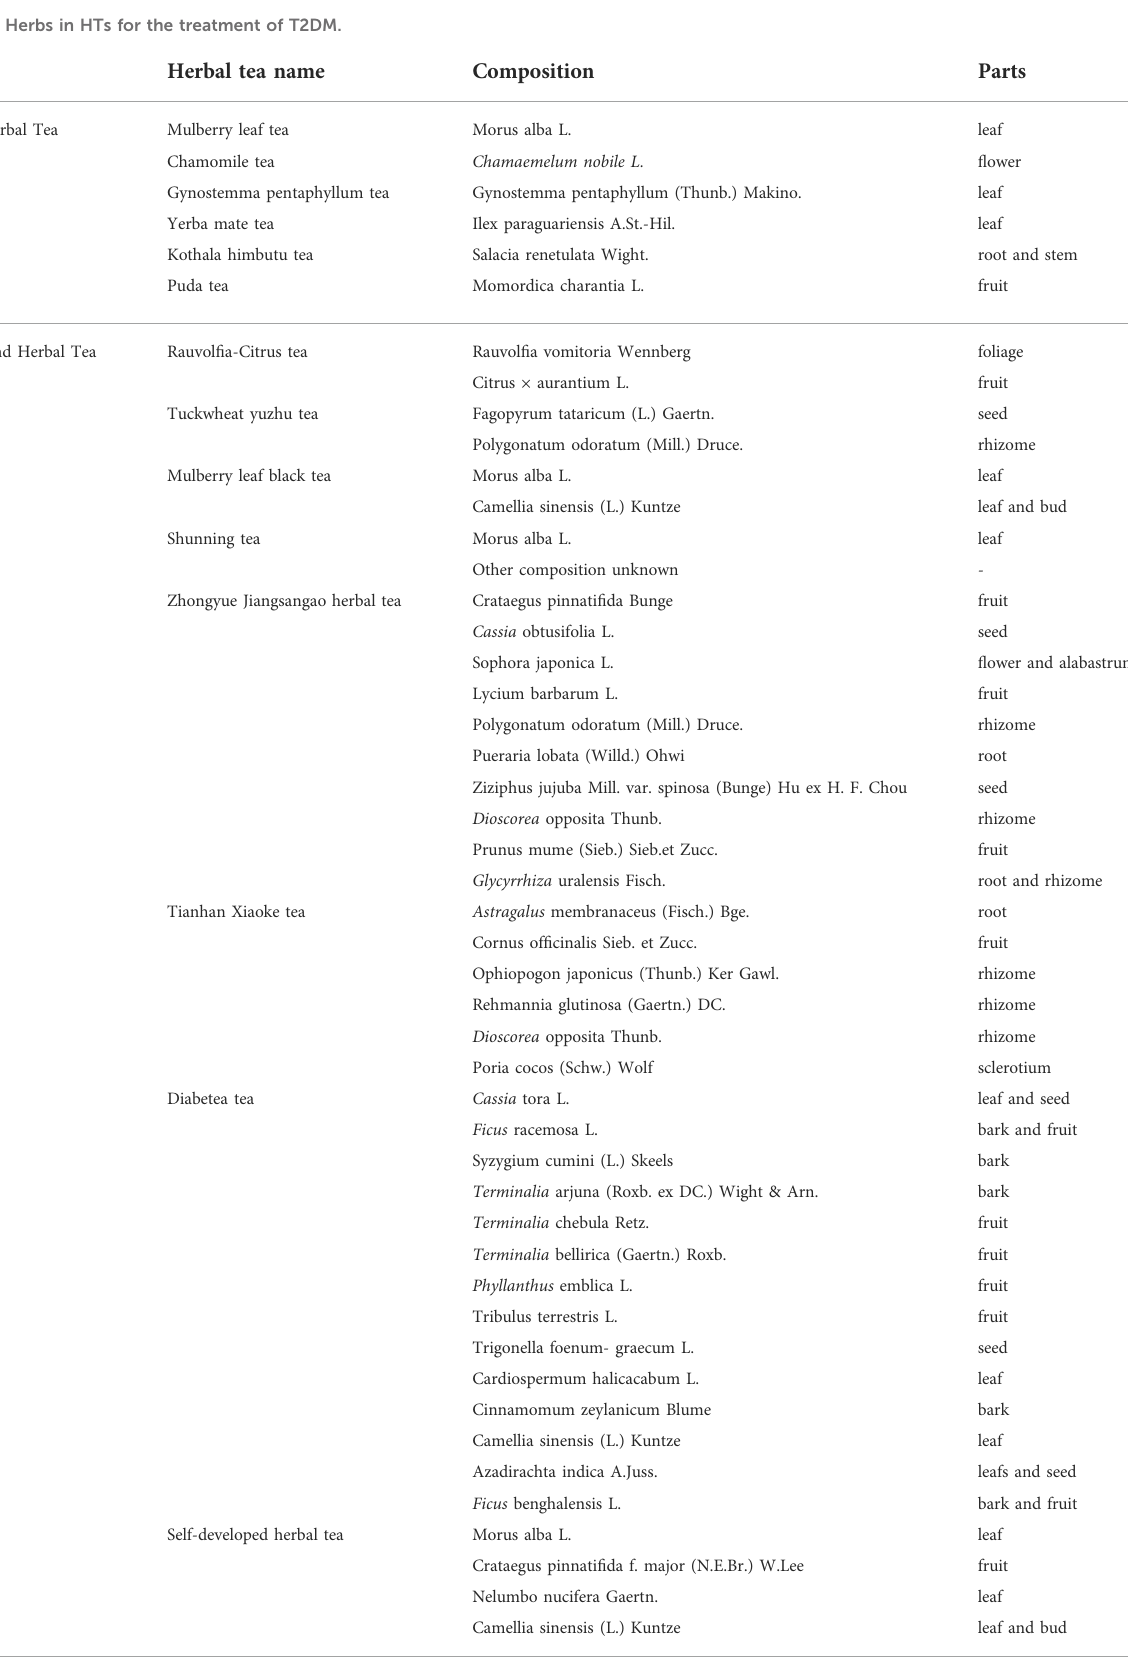
TABLE 2 Herbs in HTs for the treatment of